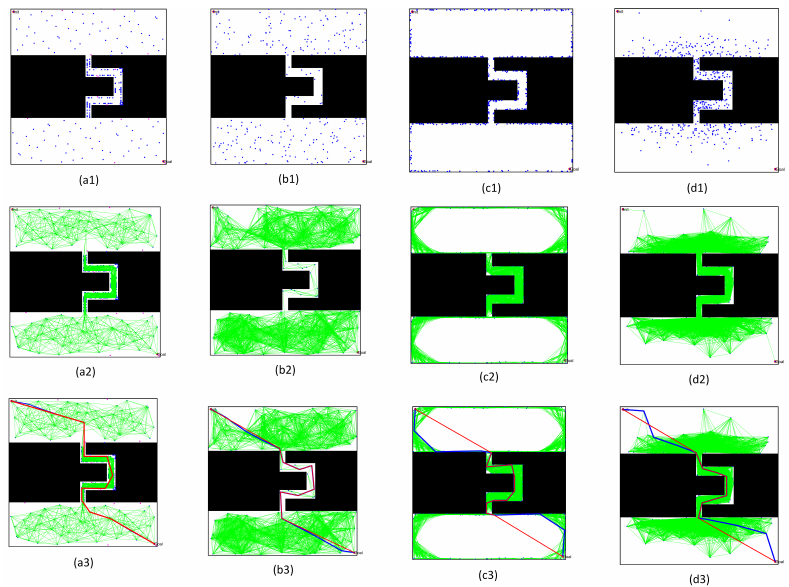
Figure 23. Results of various PRM algorithms in the environment with a non-straight channel: ( a1 – a3 ) based on the sampling method proposed in this paper; ( b1 – b3 ) based on random sampling method; ( c1 – c3 ) based on Gaussian sampling method; and ( d1 – d3 ) based on Bridge sampling